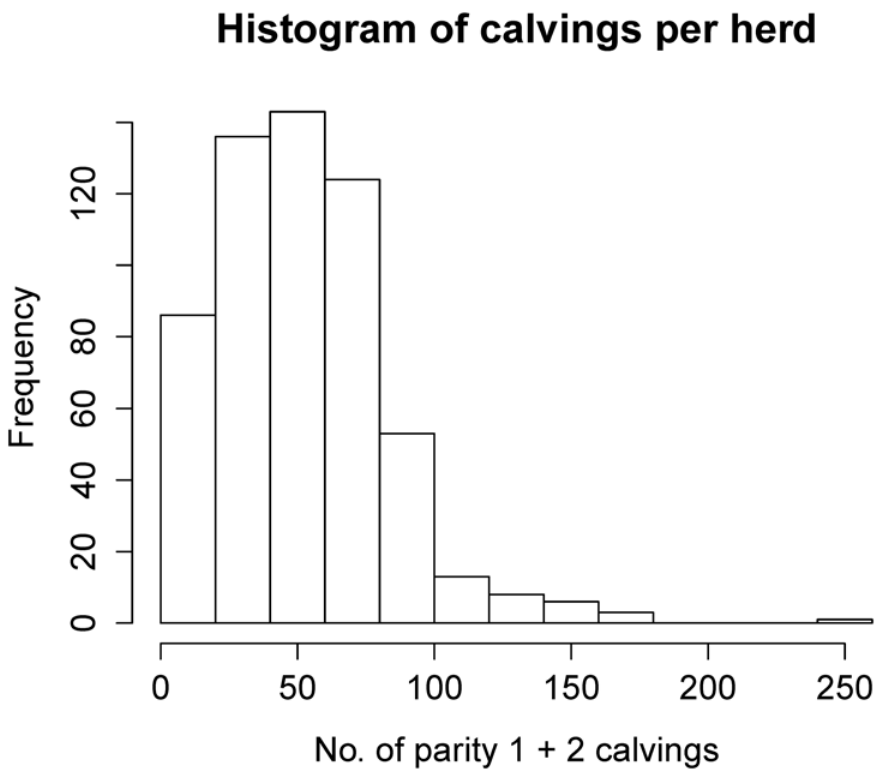
Fig 1. Histogram of calvings per herd. The number of parity 1 and 2 calvings per herd included in the study in the year